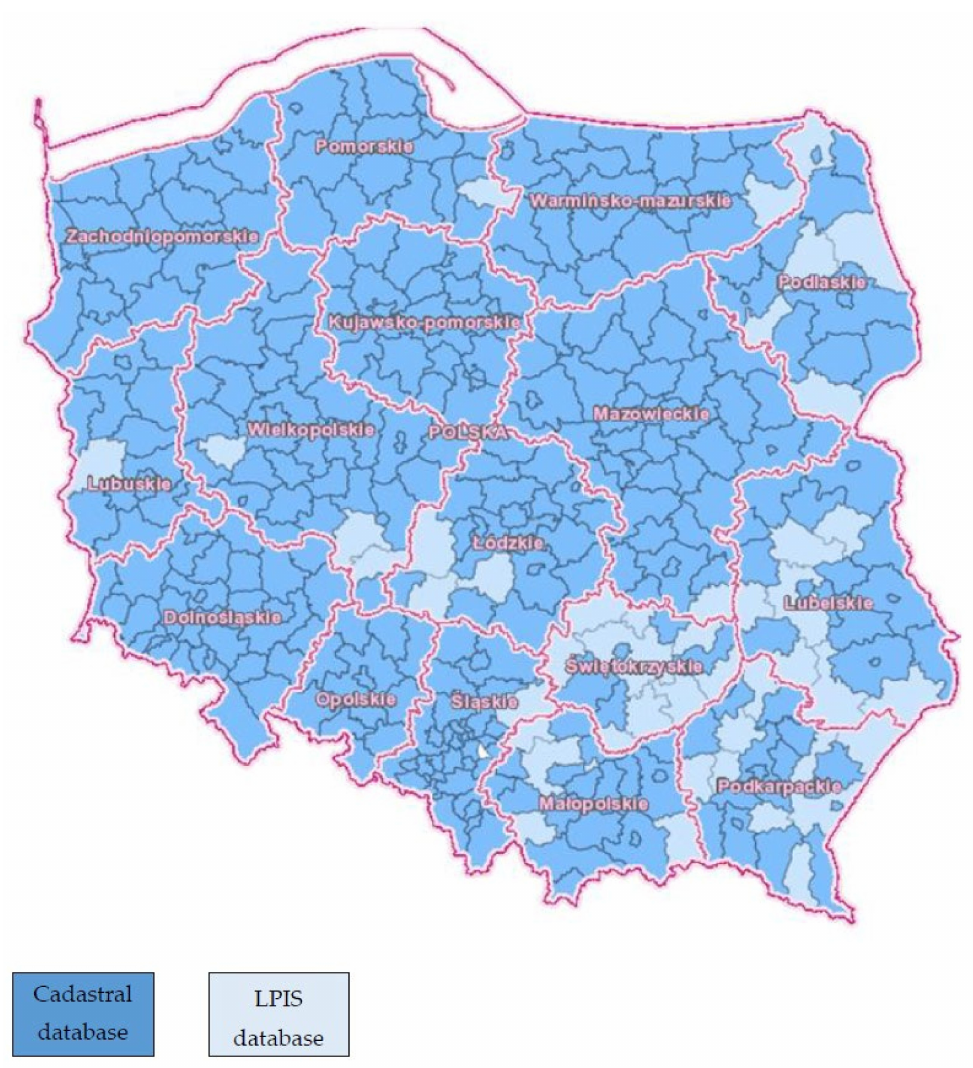
Figure 3. County infrastructure nodes in the National Integration of Land Registers (NILR)